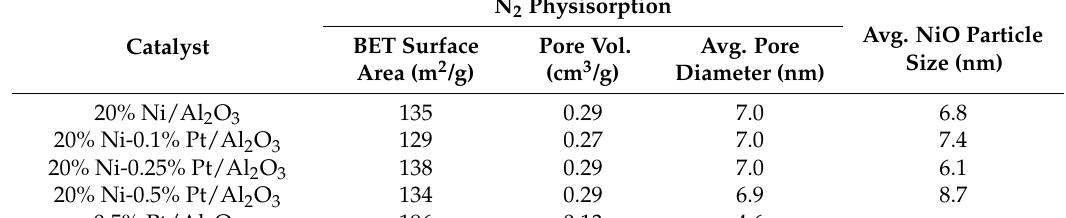
Table 1. Textural properties and metal dispersion of the catalysts studied.